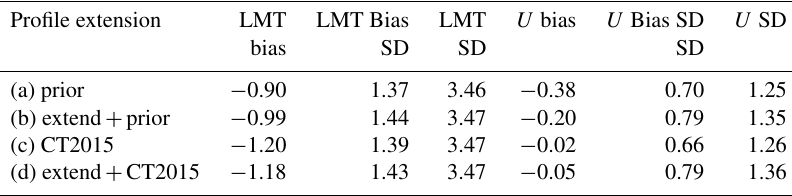
Table A4. Effect of profile extension. GOSAT corrected as described in Table A1 and compared to aircraft data with profile extended four different ways: (a) using the GOSAT prior, (b) extending the aircraft to the tropopause pressure, with the GOSAT prior above this, (c) using the CT2015 model, and (d) extending the aircraft to the tropopause pressure, with the CT2015 above this.